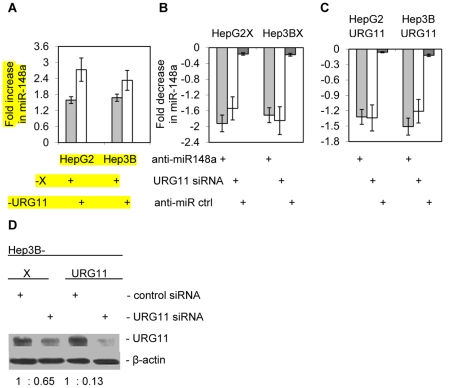
Relationship between HBx, URG11 and miR-148a expression levels.(A) Endogenous levels of miR-148a were determined in the indicated cell lines, and their levels normalized to miR-148a in CAT expressing cells. (B) Cells were transiently transfected with URG11 siRNA (white bars), anti-miR-148a (light gray bars, positive control) or control miRNA (dark gray bars), and the levels of endogenous miR-148a determined. (C) Parallel experiments as in panel A except that HepG2RG11 and Hep3BURG11 cells were used. (D) Relative levels of URG11 protein in cells transiently transfected with URG11 specific siRNA or control siRNA. The results show one of three experiments.